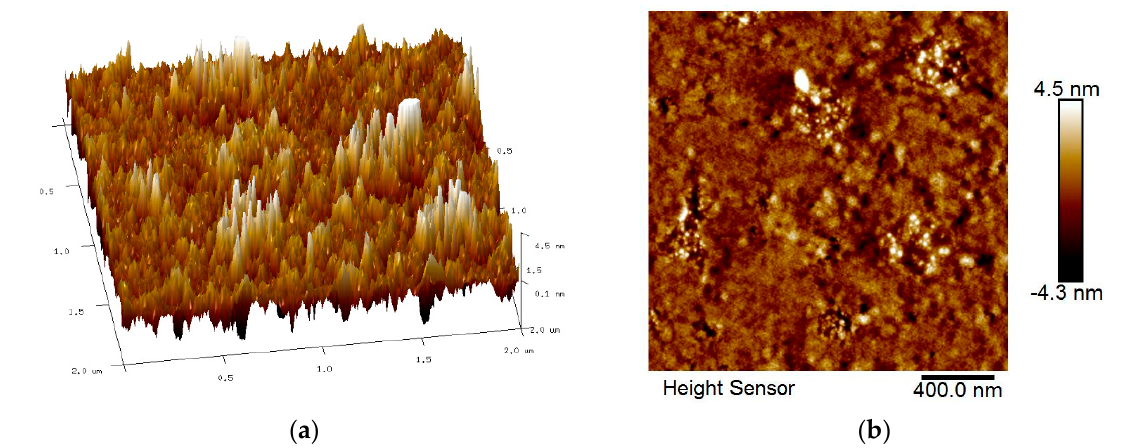
Figure 7. AFM images of GQDs − PVA thin film: ( a ) 3D image and ( b ) 2D image.